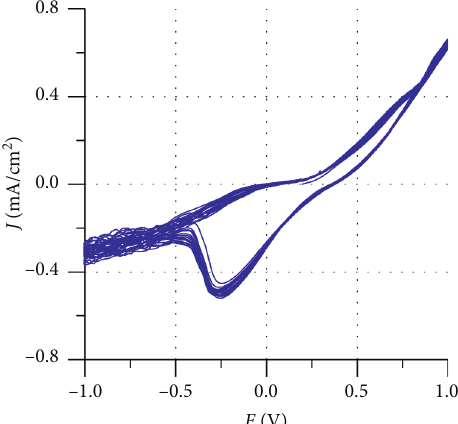
Figure 2: Array of cyclic voltamperograms of silver in RL solution (2g/L), t � 20 ° C, 20 cycles.